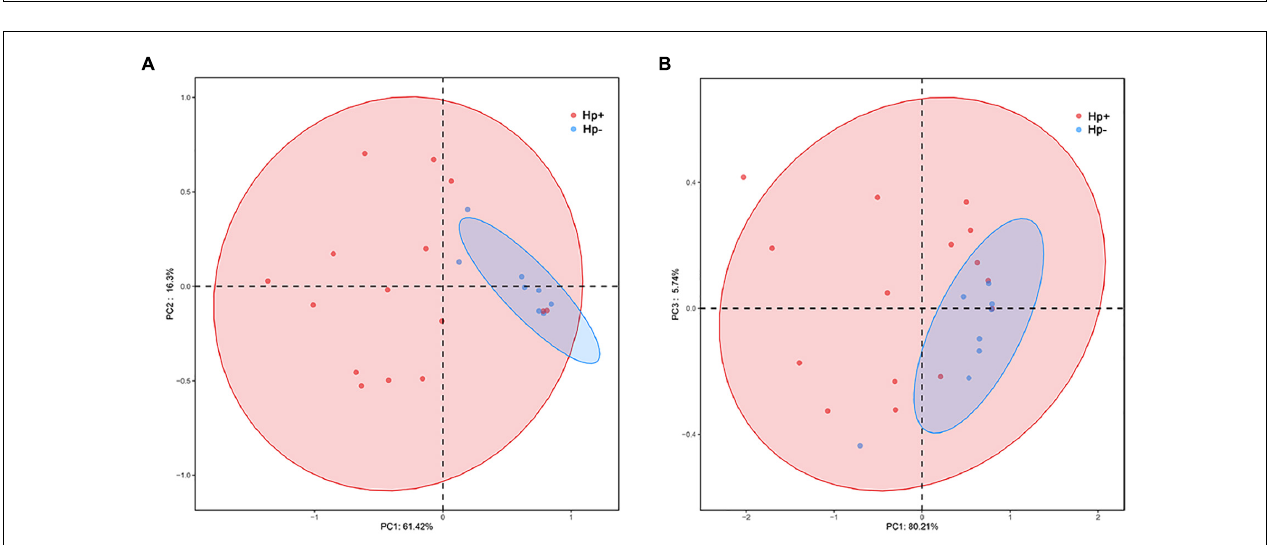
FIGURE 2 | Plots of principal coordinate analysis (PCoA) of the gastric microbiota in the two stomach microbiotas based on the Bray-Curtis distance (A) and Weighted Unifrac distance (B) . Hp+, H. pylori -positive group; Hp-, H. pylori -negative